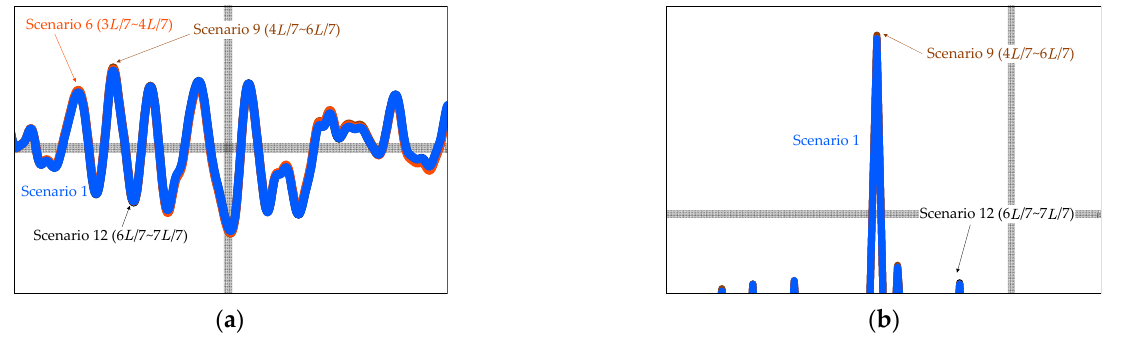
.. .. .. .. z s 1 ; ( b ) z s 2 ; ( c ) z u 1 ; and ( d ) z u 2 .